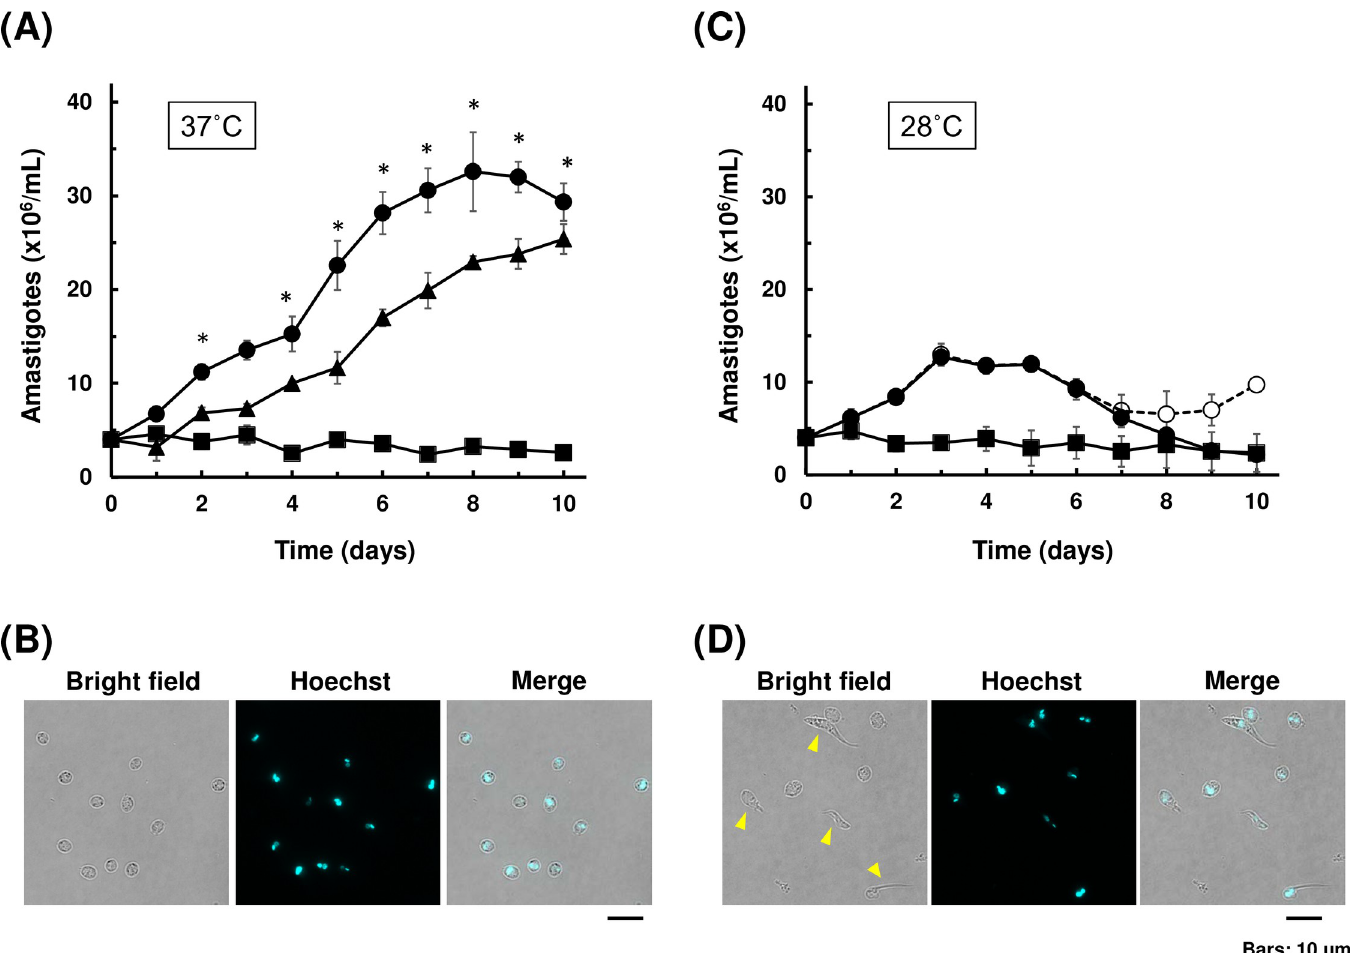
Fig 1. Growth and morphology of axenic amastigote culture. (A) Growth curves of axenic amastigotes at 37˚C. Amastigotes derived from in vitro amastigogenesis were cultured in either LIT medium (closed circle) or DMEM (closed square) at 37˚C. Intracellular amastigotes isolated from host 3T3 cells were also cultured in LIT medium (closed triangle). The number of amastigotes were counted under microscopy. At least two independent experiments were performed in triplicates for each group, and mean values ( ± SD) of one representative experiment were plotted. Significant difference compared to DMEM was indicated ( � p < 0.05, Kruskal-Wallis test). (B) Morphology of amastigote after 10 days of axenic cultivation in LIT medium at 37˚C. The parasites were fixed and stained using Hoechst 33342 to detect nucleus and kinetoplast. Scale bar: 10 μ m. (C) Growth curves of axenic amastigotes at 28˚C. Amastigotes derived from in vitro amastigogenesis were cultured in either LIT medium (closed and open circles) or DMEM (closed square) at 28˚C. For LIT 28˚C, closed circle represents the number of round form amastigote only, and open circle represents the total number of parasites including intermediate morphologies. At least two independent experiments were performed in triplicates for each group, and mean values ( ± SD) of one representative experiment were plotted. No significant difference was observed among groups (Kruskal-Wallis test). (D) Representative image of parasites displaying intermediate morphology after 10 days of axenic cultivation at 28˚C (open circle in (C)). Parasites with intermediate forms are indicated by arrow heads.